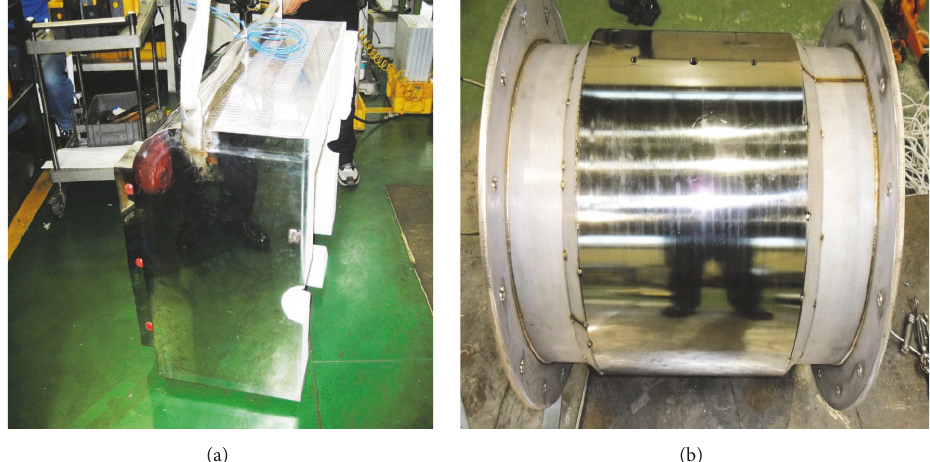
Figure 21: Testing the assembling and disassembling possibility of modules: (a) heater; (b)